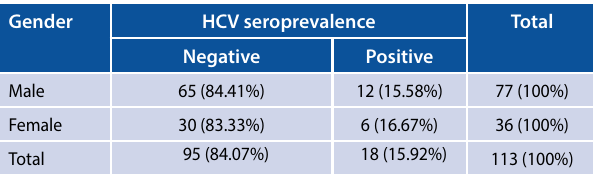
Table 2: Seroprevalence of HCV according to gender of subjects ( N = 113)